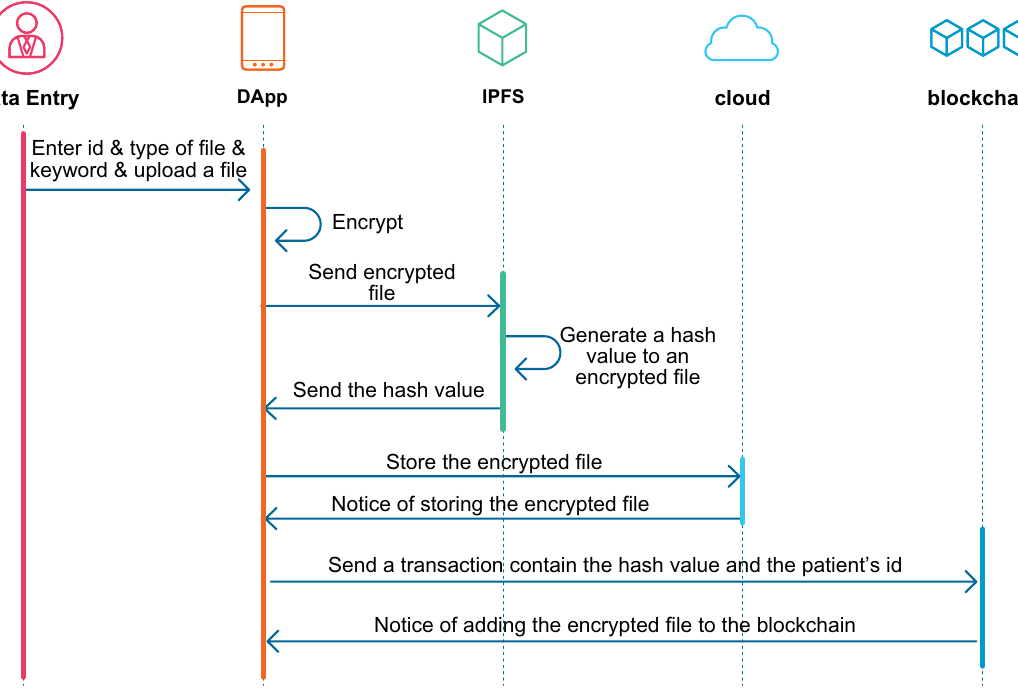
Figure 2. A sequence diagram of the process of adding files process to the system. The process starts by uploading a file, encrypting it, sending it to the IPFS to generate a hash, and then storing it in the cloud and